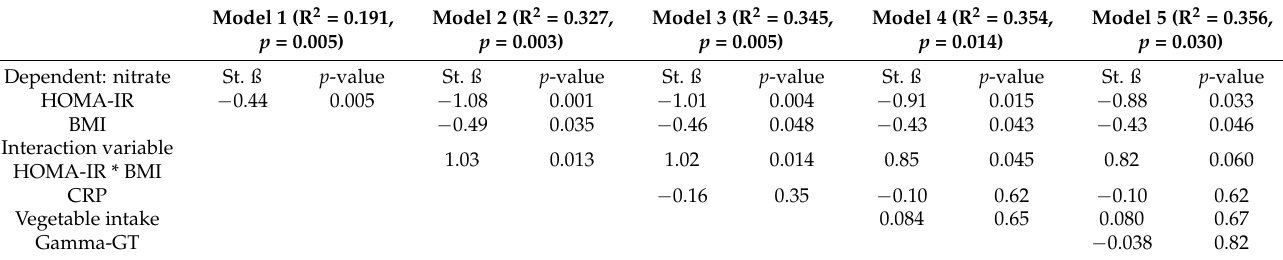
Table 2. Nitrate and HOMA-IR: multivariate linear regression